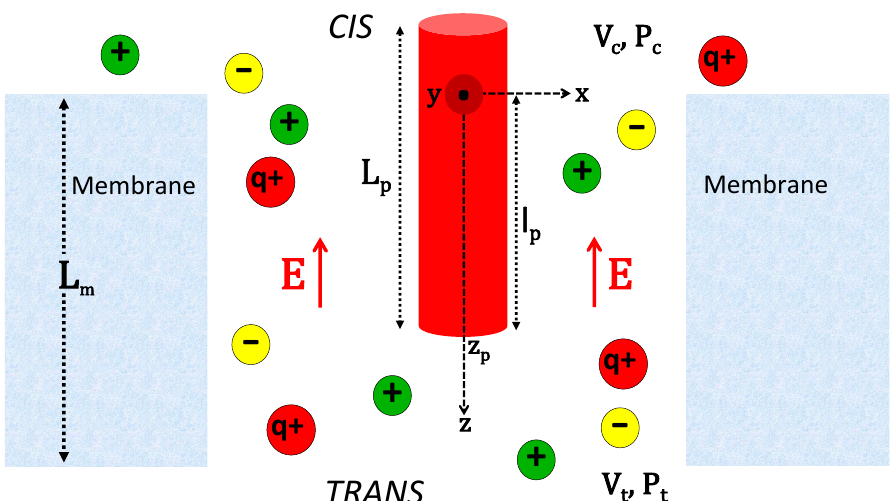
Figure 1. Schematic of a polymer translocating through a cylindrical pore of radius d , length L m , and negative surface charge density − σ m . The anionic polymer translocating on the z axis is a cylinder of length L p , radius a , and surface charge density − σ p . l p is the length of the polymer portion located in the pore. Translocation is driven by the externally applied voltage ∆ V = V t − V c , resulting in the electric field E = − ∆ V / L m ˆ u z , and the hydrostatic pressure ∆ P = P c − P t